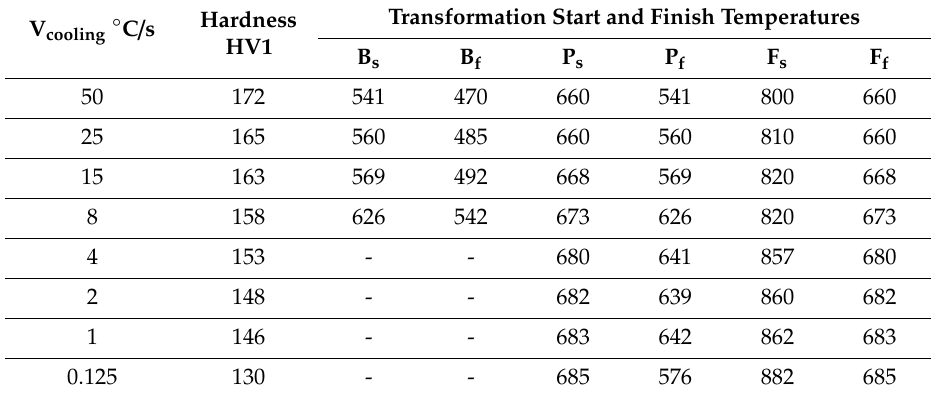
Table 5. Transformation start and finish temperatures are determined based on dilatometric analysis for deformed samples.